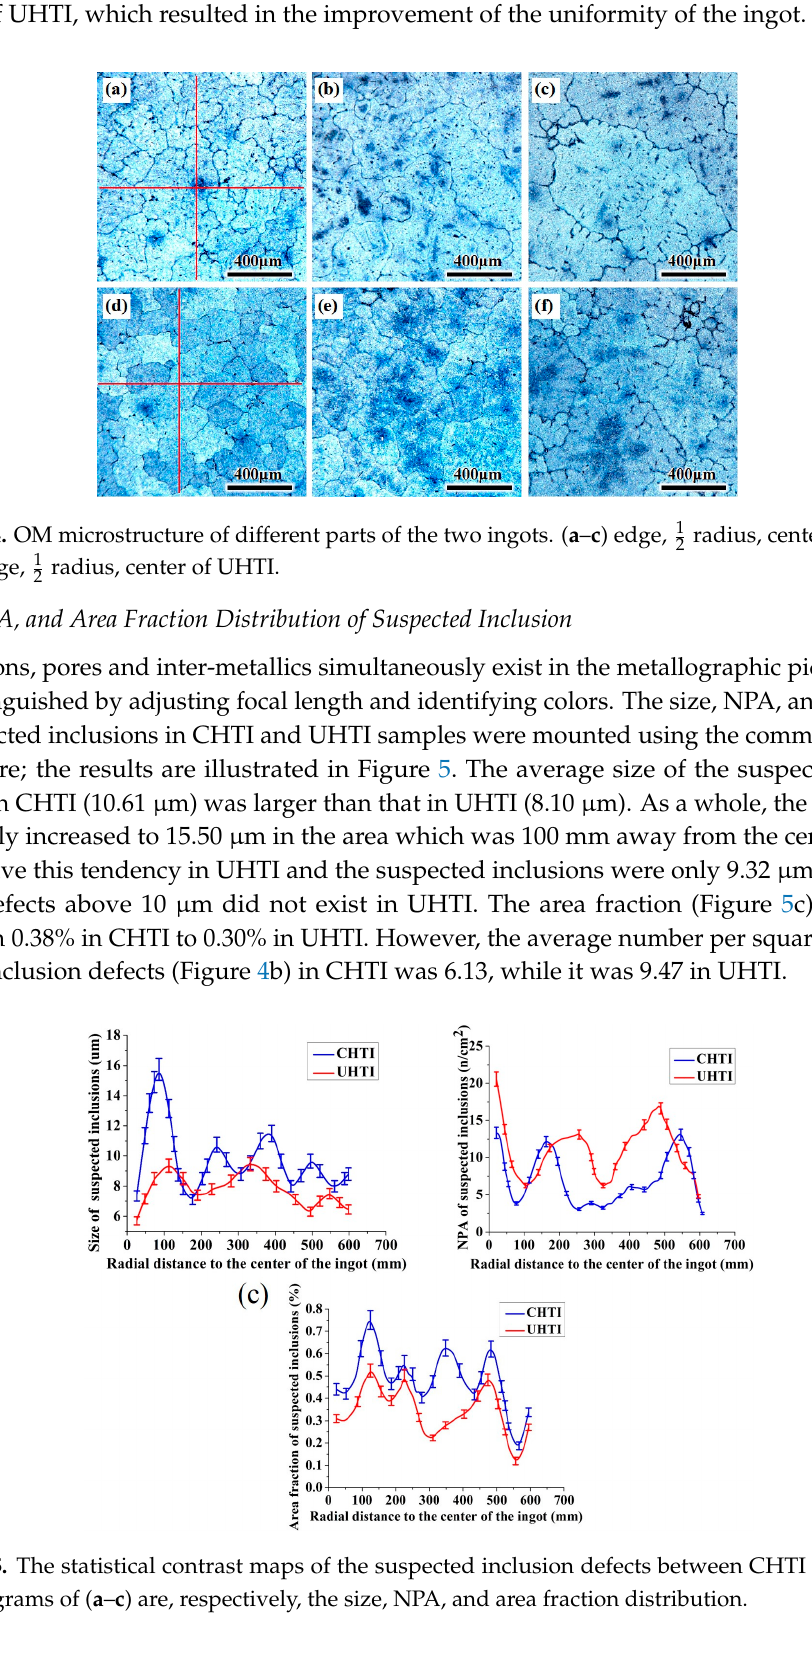
Figure 5. The statistical contrast maps of the suspected inclusion defects between CHTI and